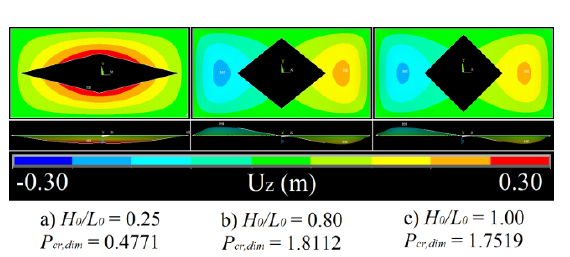
Figure 13. Comparison of the optimized buckled shape of plate with rectangular, diamond and elliptical hole for the hole vol- ume fraction of